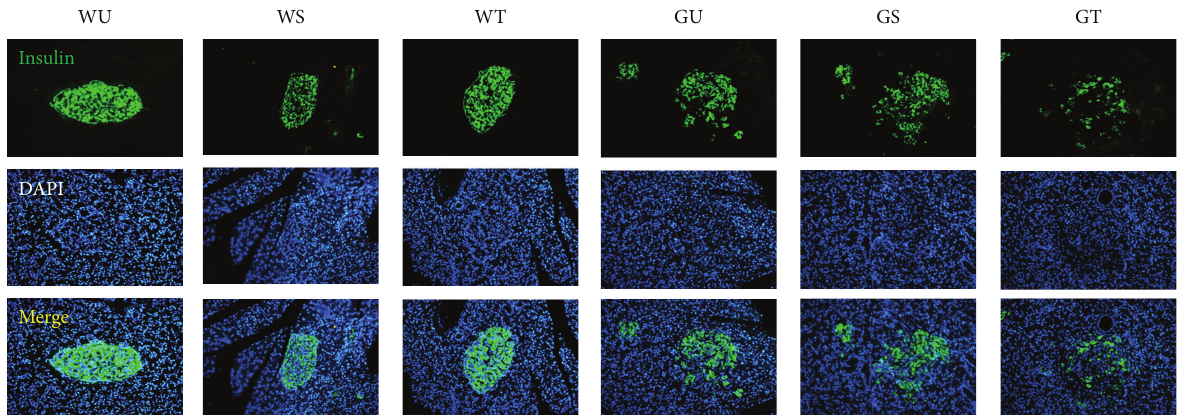
Figure 2: Transplanted PSCs reduce 𝛽 -cell mass in vivo . Insulin immunofluorescent staining was performed on pancreatic sections. Representative images of insulin immunofluorescence staining (green) and nuclei labeled by DAPI (blue) were shown. All images were taken at the same magnification ( ×